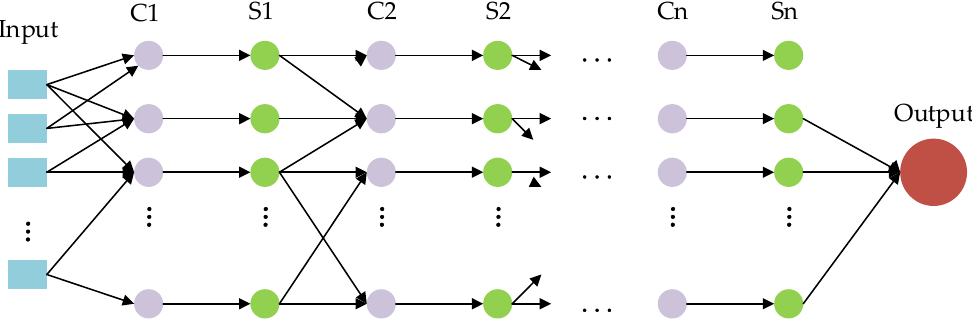
Figure 2. The typical structure of a deep convolutional neural network (DCNN).